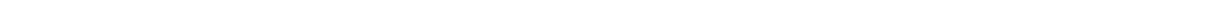
Fig. 3 LPS upregulates Mirt2 in macrophages via p38-Stat1 and IFN-Stat1 signaling. a Cultured peritoneal macrophages were pretreated with